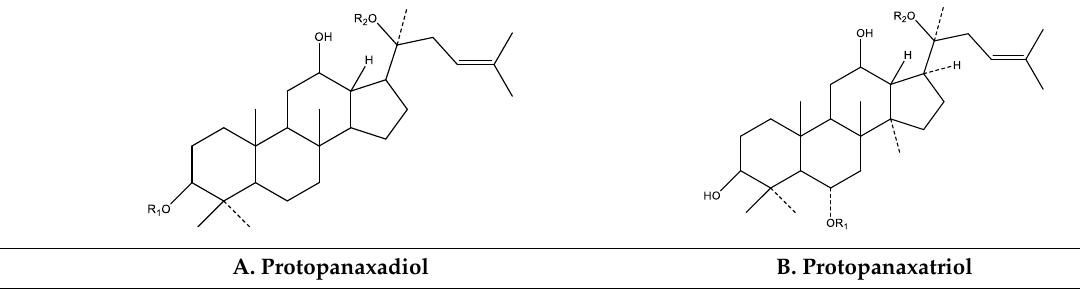
Table 2. Structure of ginsenosides (ginseng-specific saponins).